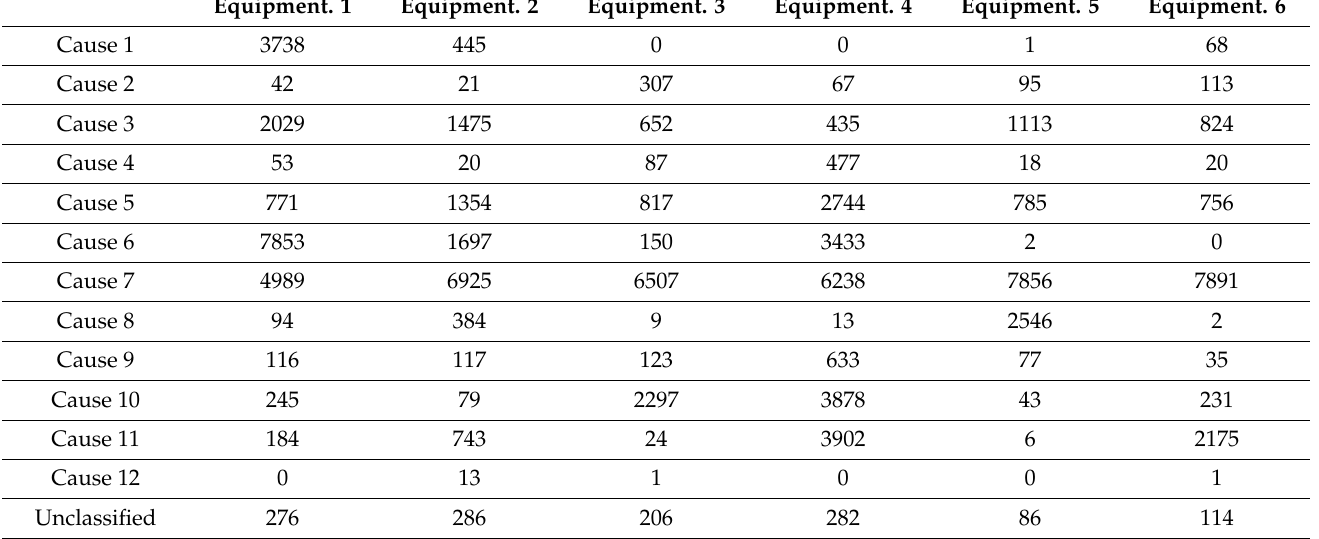
Table 4. Cause classification result shows the frequency of occurrence by each